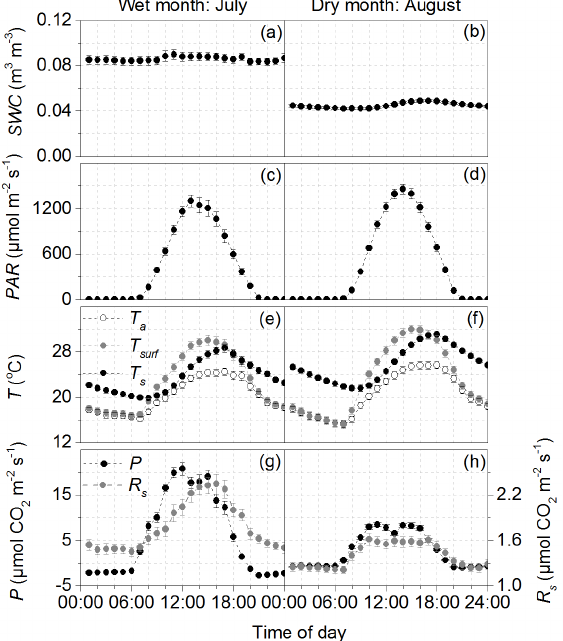
Figure 2. Mean monthly diel cycle of soil water content (SWC), in- cident photosynthetically active radiation (PAR), temperature (i.e., air ( T a ) , soil-surface ( T surf ) , and soil temperatures ( T s ) ), soil res- piration ( R s ) , and photosynthesis ( P) at an Artemisia ordosica - dominated site during a wet and dry month. Each point is the monthly mean for a particular time of day. Bars represent standard errors.